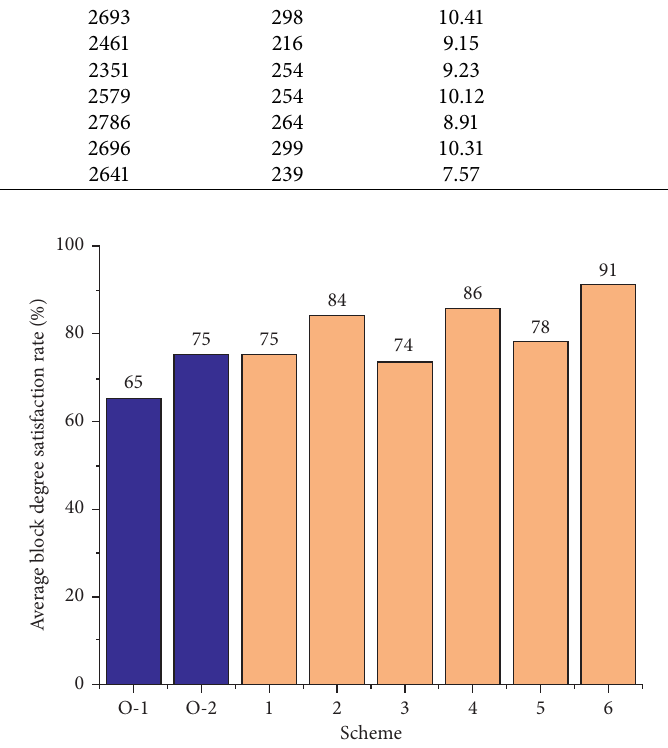
Figure 7: Statistical chart of satisfaction rate of blasting effect.